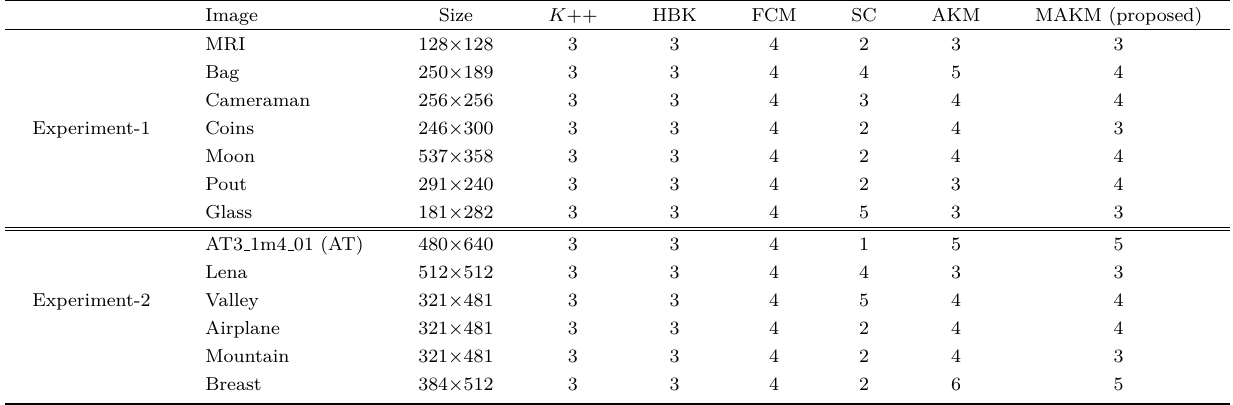
Table 1 Number of clusters used in each algorithm for each respective images